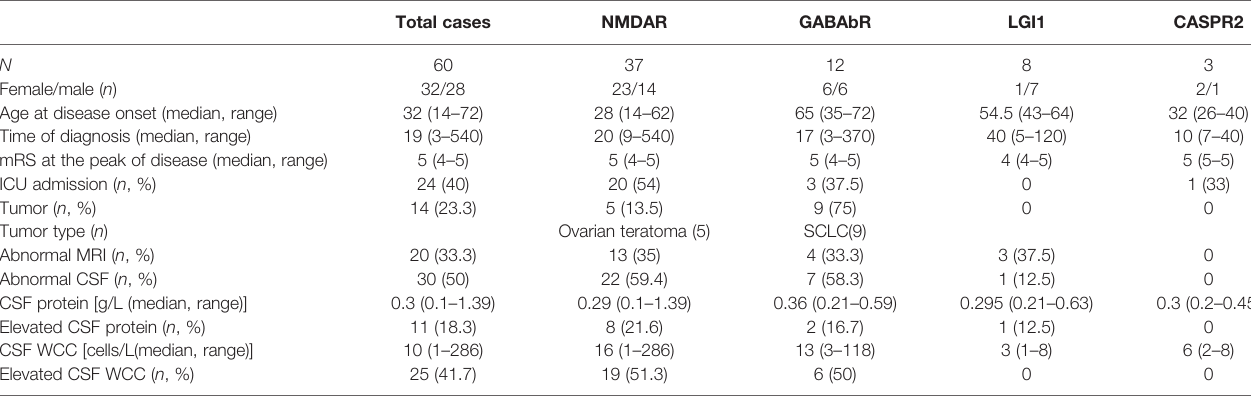
TABLE 1 | Characterization of the whole